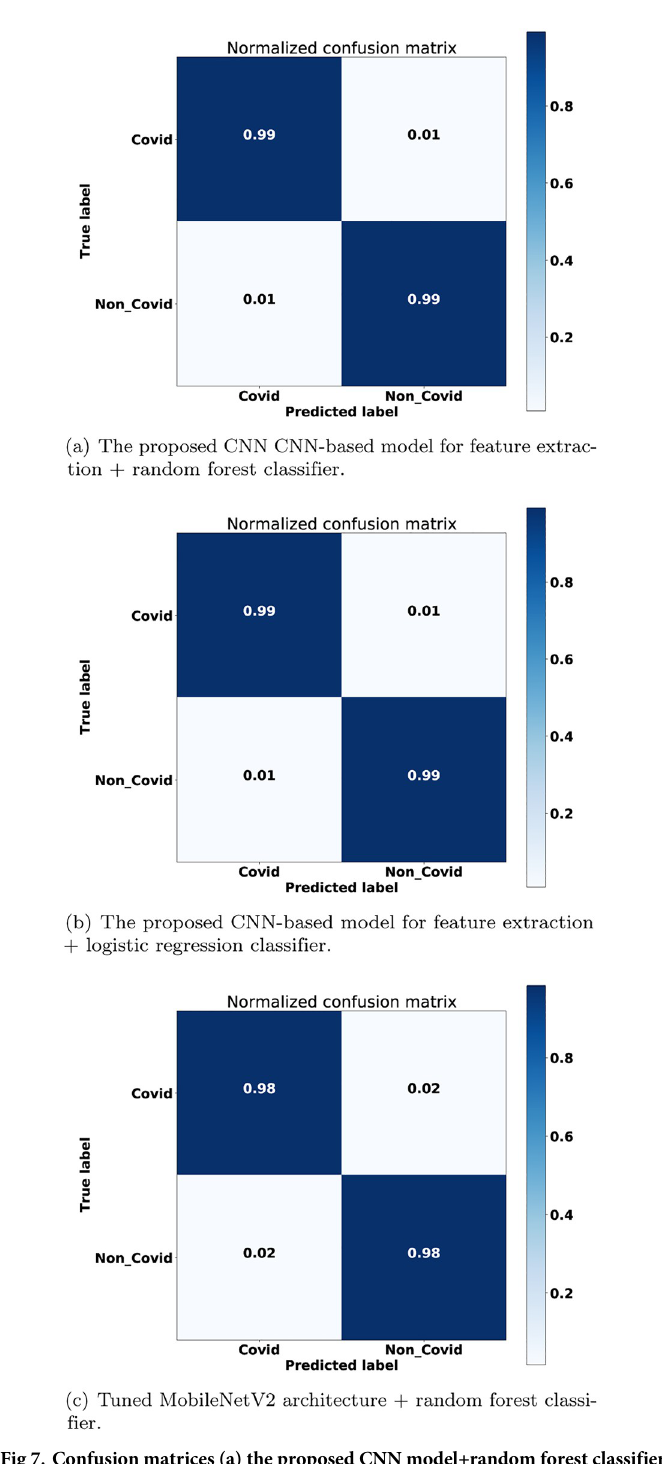
Fig 7. Confusion matrices (a) the proposed CNN model+random forest classifier (b) the proposed CNN model +logistic regression classifier (c) tuned MobileNetV2 + random forest classifier.